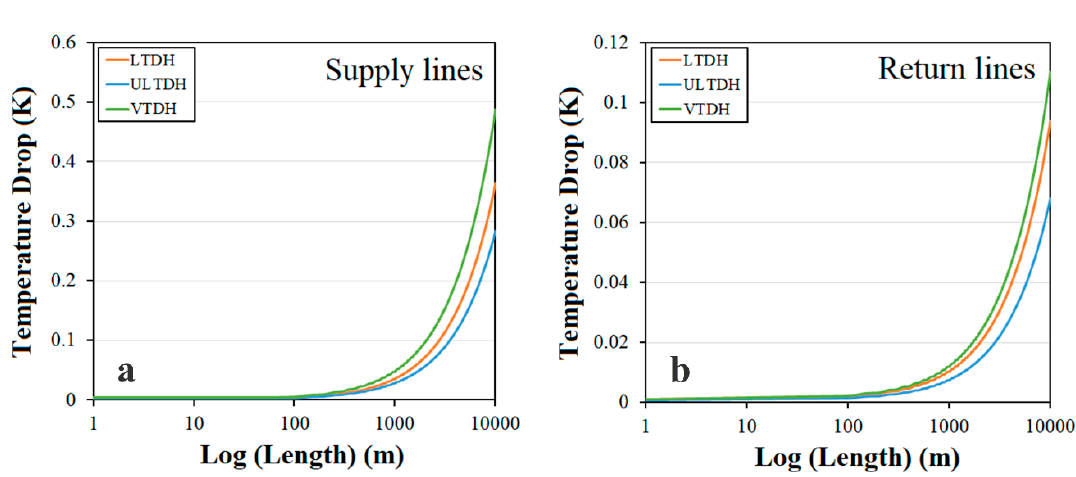
Figure 7. The rate of temperature fall along the pipeline for the three scenarios when the same mass flow rate is applied. ( a ) supply lines ( b ) return lines.